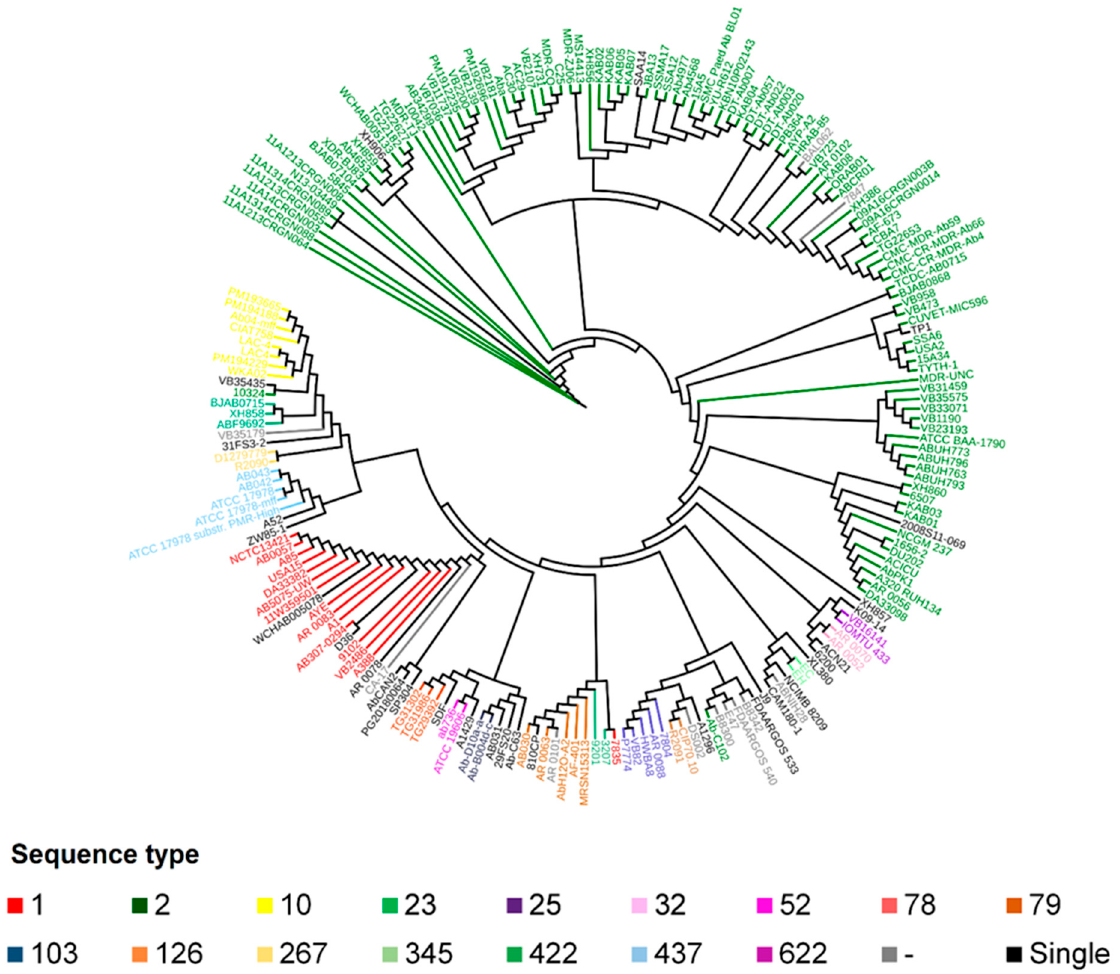
Figure 2. Phylogenomic tree based on the core genome of 206 Acinetobacter baumannii strains. The colors represent the grouping by sequence type. The method used was maximum likelihood with statistical support of 1000 bootstraps with 1999 genes present in the core genome.